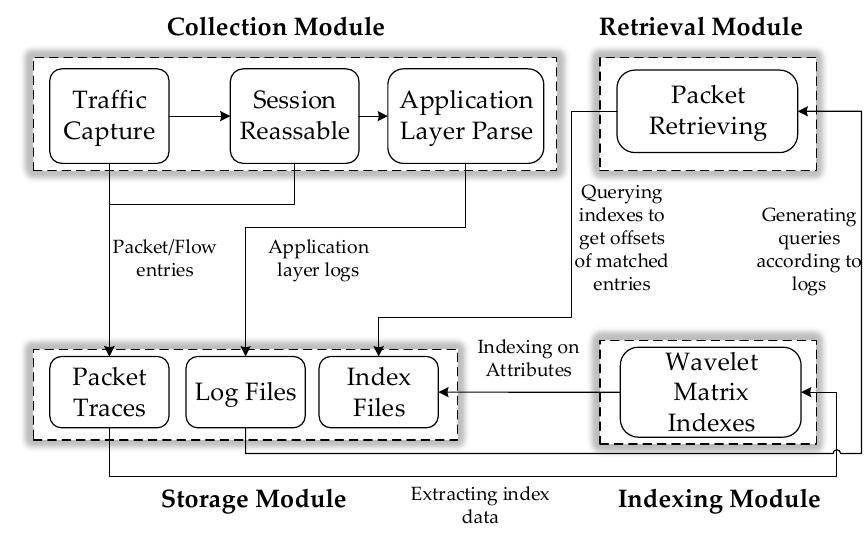
Figure 3. The architecture of the network traffic collection and retrieval system.